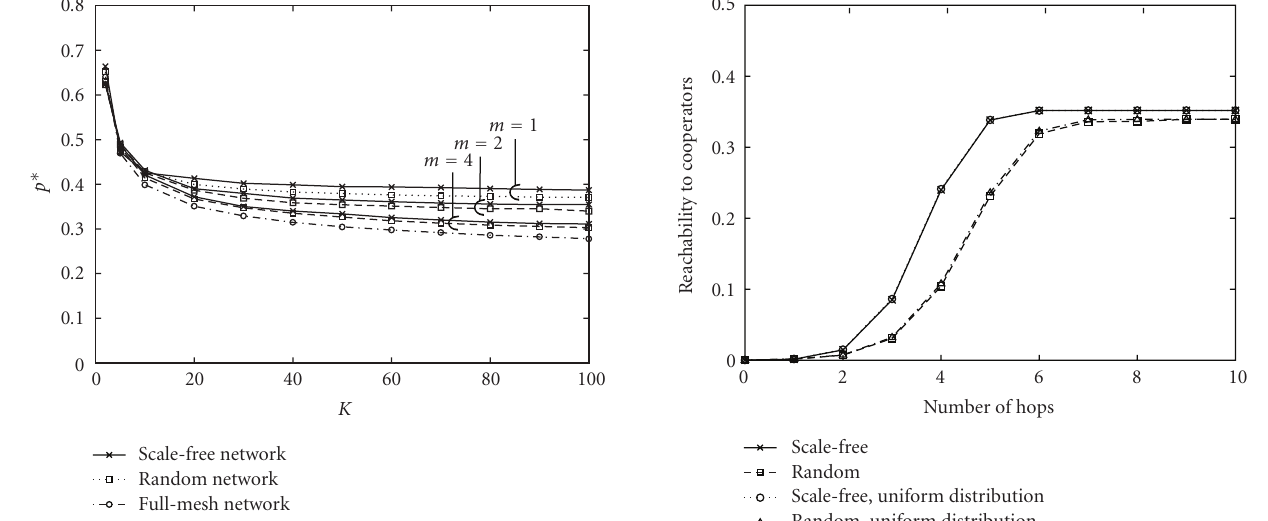
Figure 6: File availability p ∗ as a function of K .